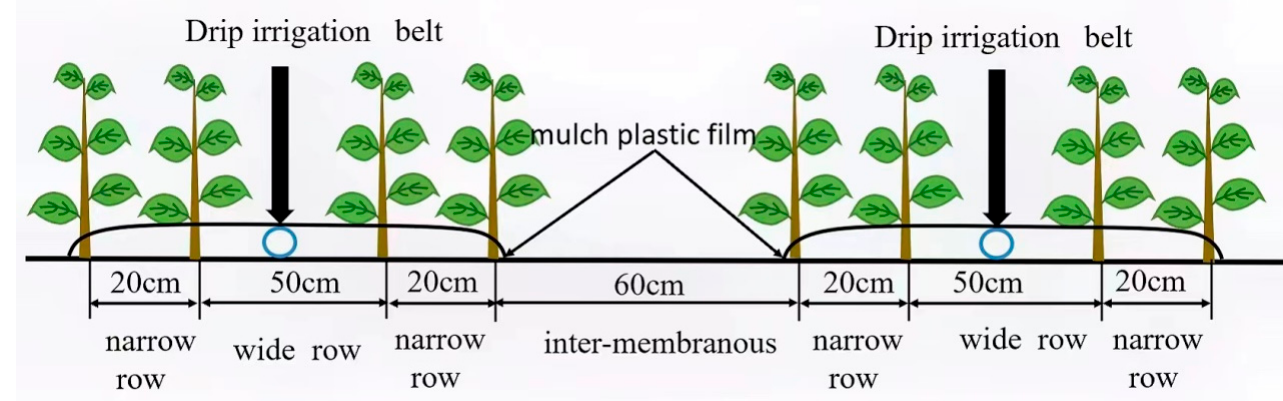
Figure 1. Cotton and drip irrigation belt arrangement in the field.